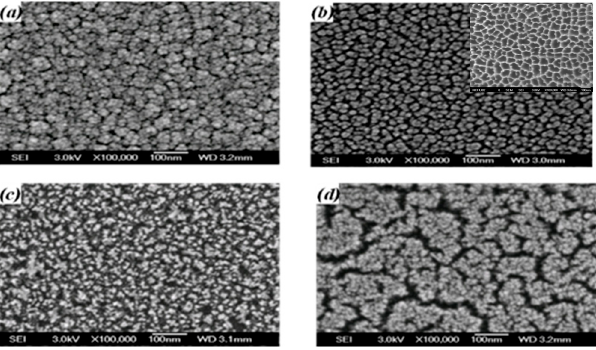
Figure 3. Surface morphologies of the ( a ) untreated a-TiO x film; and SFE-treated a-TiO x film for ( b ) 10; ( c ) 20; and ( d ) 35 s, respectively (the AAM patterns is provided in inset figure of Figure 3b).